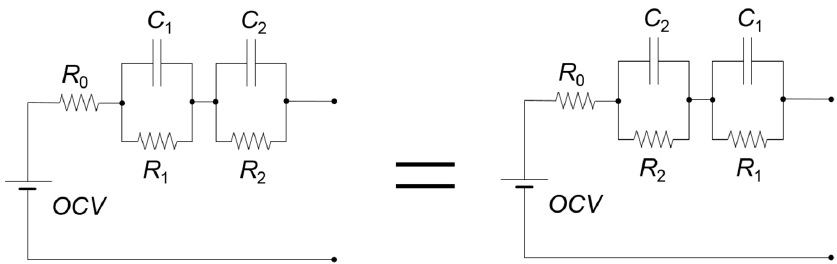
Figure 2. Diagram to illustrate that the second-order resistor–capacitor (RC) network has two solutions. OCV : open-circuit voltage.